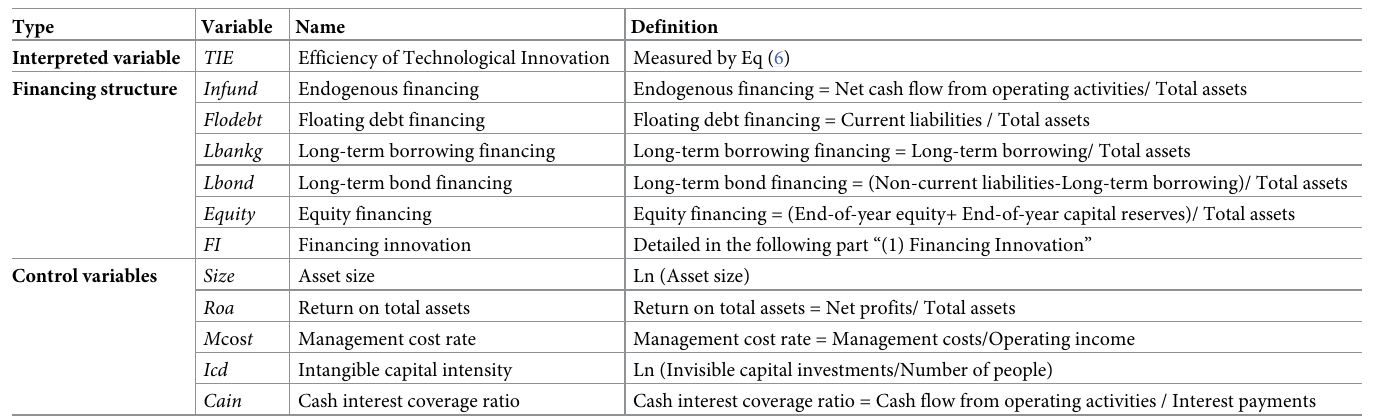
Table 5. Variable definitions.